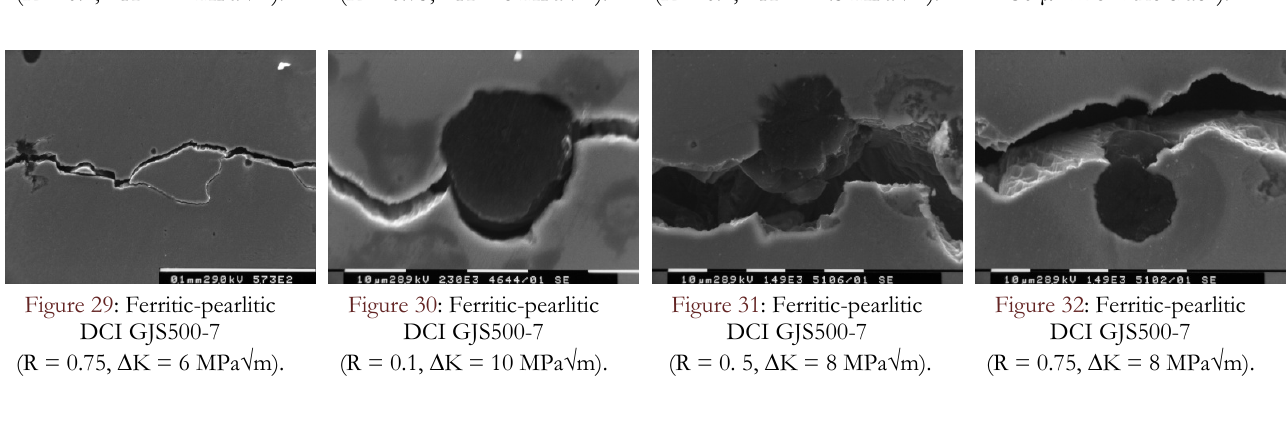
Figure 27: Pearlitic DCI (R = 0.1,  K = 11.5 MPa √ m).